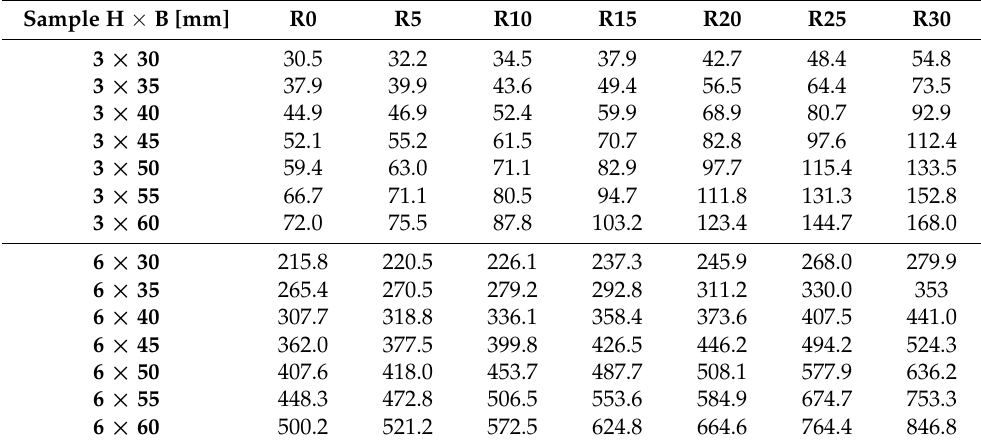
Table 3. Results of the bench experiment. Torsional moment Ms [Nm] for 20 ◦ twist, depending on the package’s cross-section dimensions (H × B) and expansion R [mm].